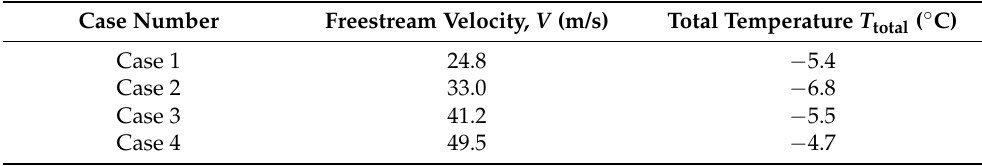
Table 3. Test conditions for roughness measurement.